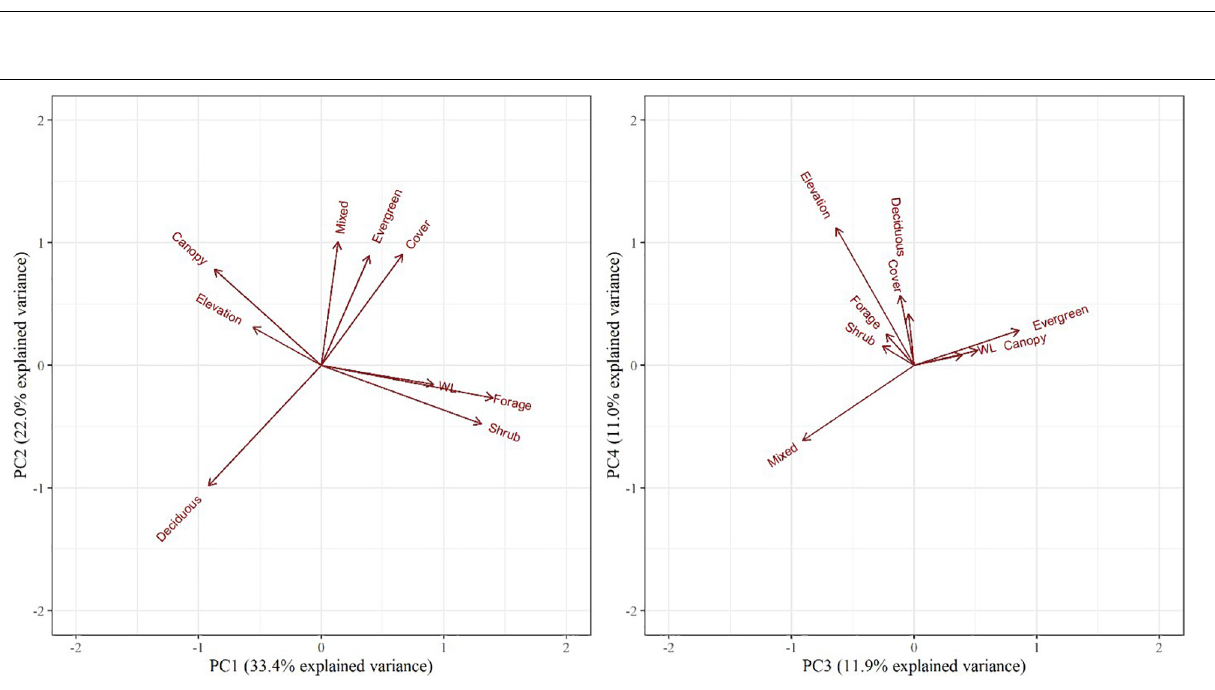
FIGURE 6 | Extinction and colonization probabilities by patch (1 km 2 ) for female moose ( Alces alces ; n = 74) in northeastern, Vermont, United States during two important winter tick ( Dermacentor albipictus ) life cycle periods (fall questing and spring drop-off). Map (A) shows the extinction probability from the tick questing to the spring drop-off period, while map (B) shows the extinction probability from the tick drop-off to the questing period. Map (C) shows the colonization probability from the tick questing to the spring drop-off period, while map (D) shows the colonization probability from the tick drop-off to the questing period.